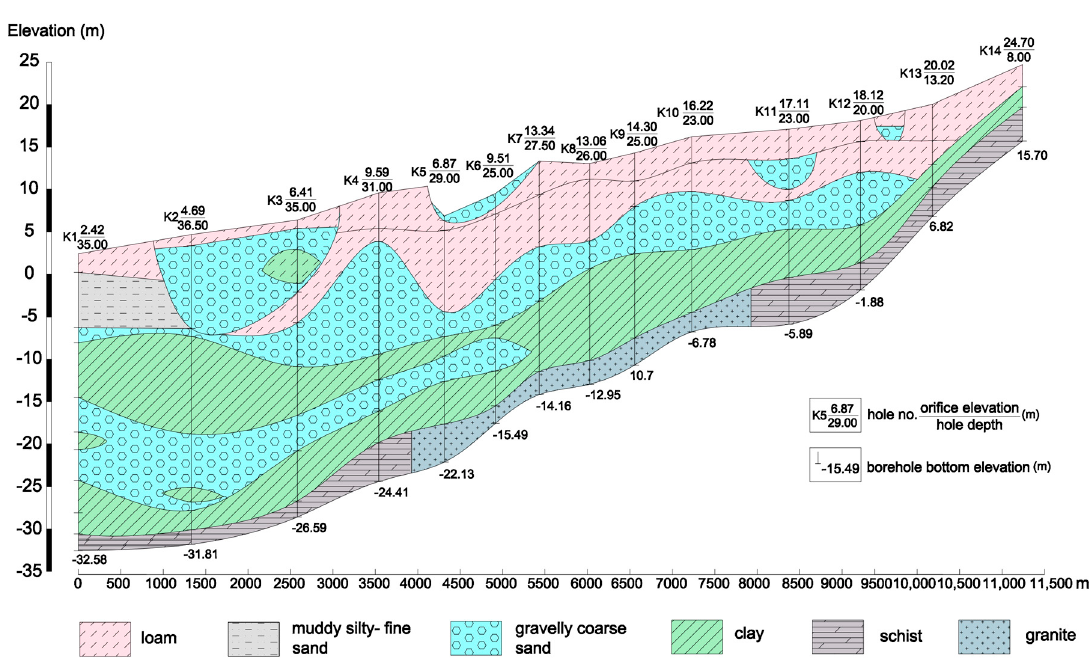
Figure 4. Hydrogeological cross-section (A-A’ profile in Figure 3).